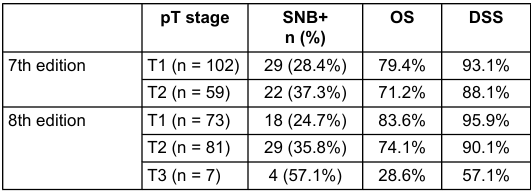
Table 1: Numbers of patients (regarding sentinel node status, overall and disease specific survival) staged according to either the 7th or the 8th edition of the TNM system.